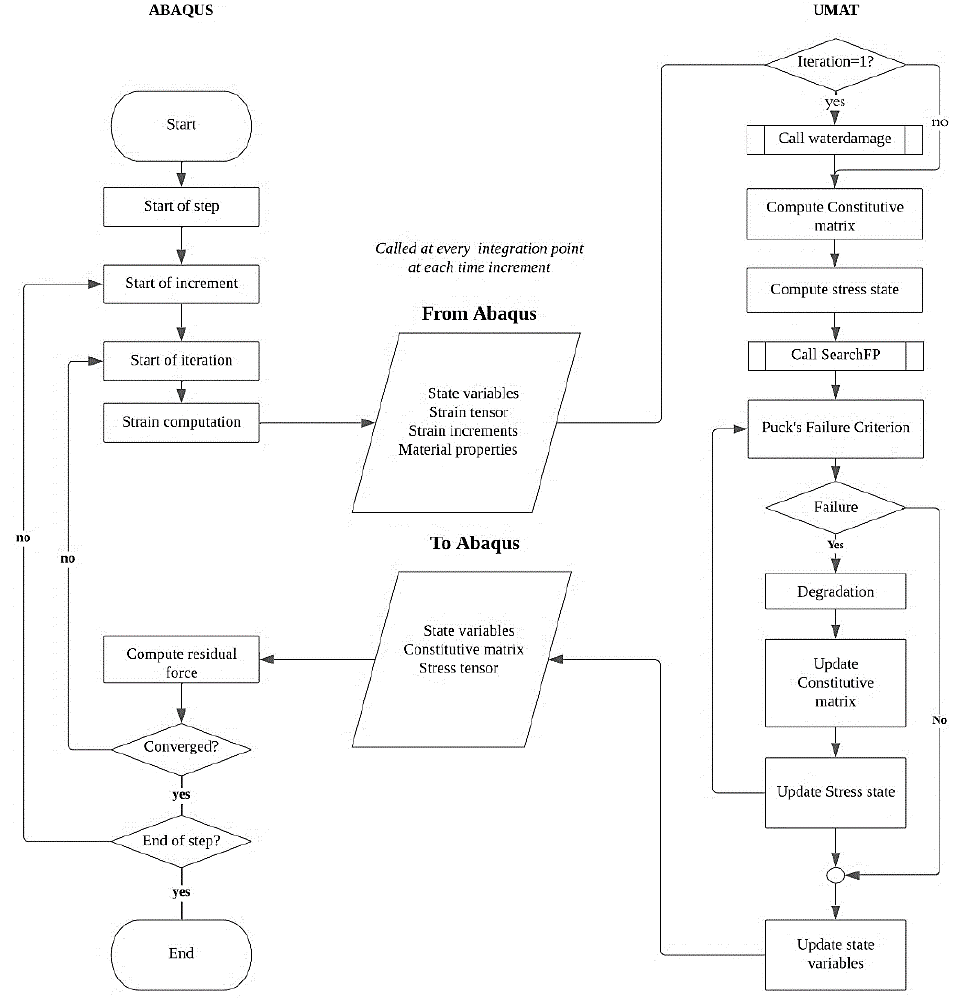
Figure 2. Algorithm of the 3D-FE iterative procedure developed in this study.